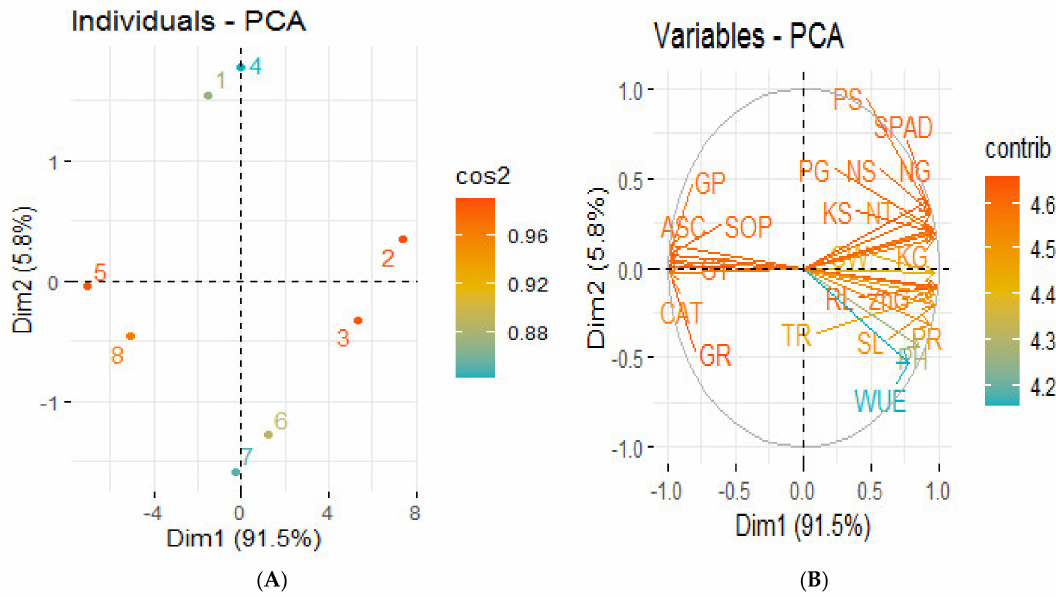
Figure 4. Principal component analysis (PCA) showing score plots ( A ) and loading plots ( B ) of di ff erent attributes of wheat plant under salt stress. Score plot ( A ) represents separation of treatments as Normal soil—(1) Control, (2) ZnSO 4 -coated urea, (3) BAZ-coated urea, and (4) Bacillus sp. strain AZ6—and Saline soil—(5) Control, (6) ZnSO 4 -coated urea, (7) BAZ-coated urea, and (8) Bacillus sp. strain AZ6. Loading plot ( B ) shows the loading of each studied variable (arrows), and the arrow lengths approximate their variance, whereas the angles between them represent their correlations. The abbreviations are as follows: PH = Plant height, RL = Root length, NT = No. of tillers, SL = Spike length, GW = 1000-grainweight, WUE = Waterusee ffi ciency, SPAD = Chlorophyllcontents, PR = Photosynthetic rate, TR = Transpiration rate, CAT = Catalase, ASC = Ascorbate peroxidase, SOD = Superoxide dismutase, GR = Glutathione reductase, GT = Glutathione transferase, GP = Glutathione peroxidase, NG = Nitrogen in grain, NS = Nitrogen in straw, PG = Phosphorus in grain, PS = Phosphorus in straw, KG = Potassium in grain, KS = Potassium in straw, and ZnG = Zinc in grain. Dim: Dimension; Cos2: Square cosine; Contrib: